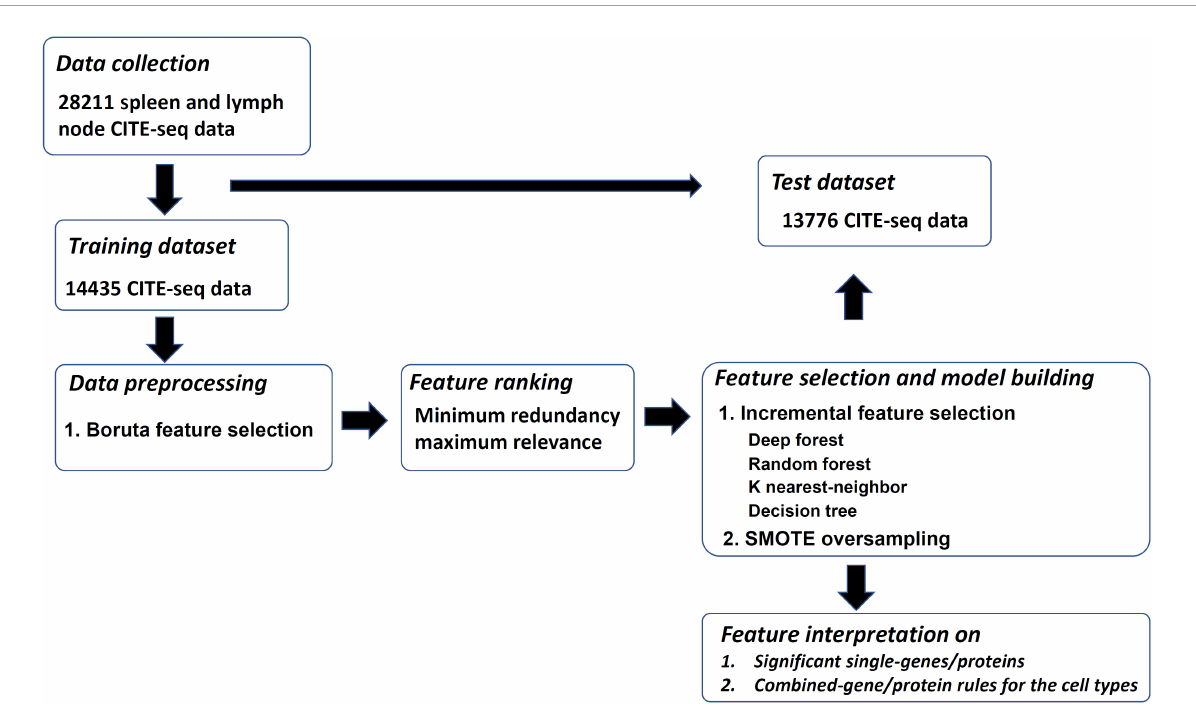
FIGURE1 Overview of the design. The training and test datasets for spleen and lymph are investigated. The training dataset is analyzed by the feature selection methods of Boruta and minimum redundancy maximum relevance one by one. The mRMR feature list is generated, which is further fed into incremental feature selection (IFS) method, incorporating four classification algorithms, to extract significant single-genes/proteins and combined-gene/protein rules. The SMOTE is applied in the IFS method to reduce the influence of imbalanced problem. The optimal classifiers yielded by the IFS method are applied on the test dataset to evaluate their generalization